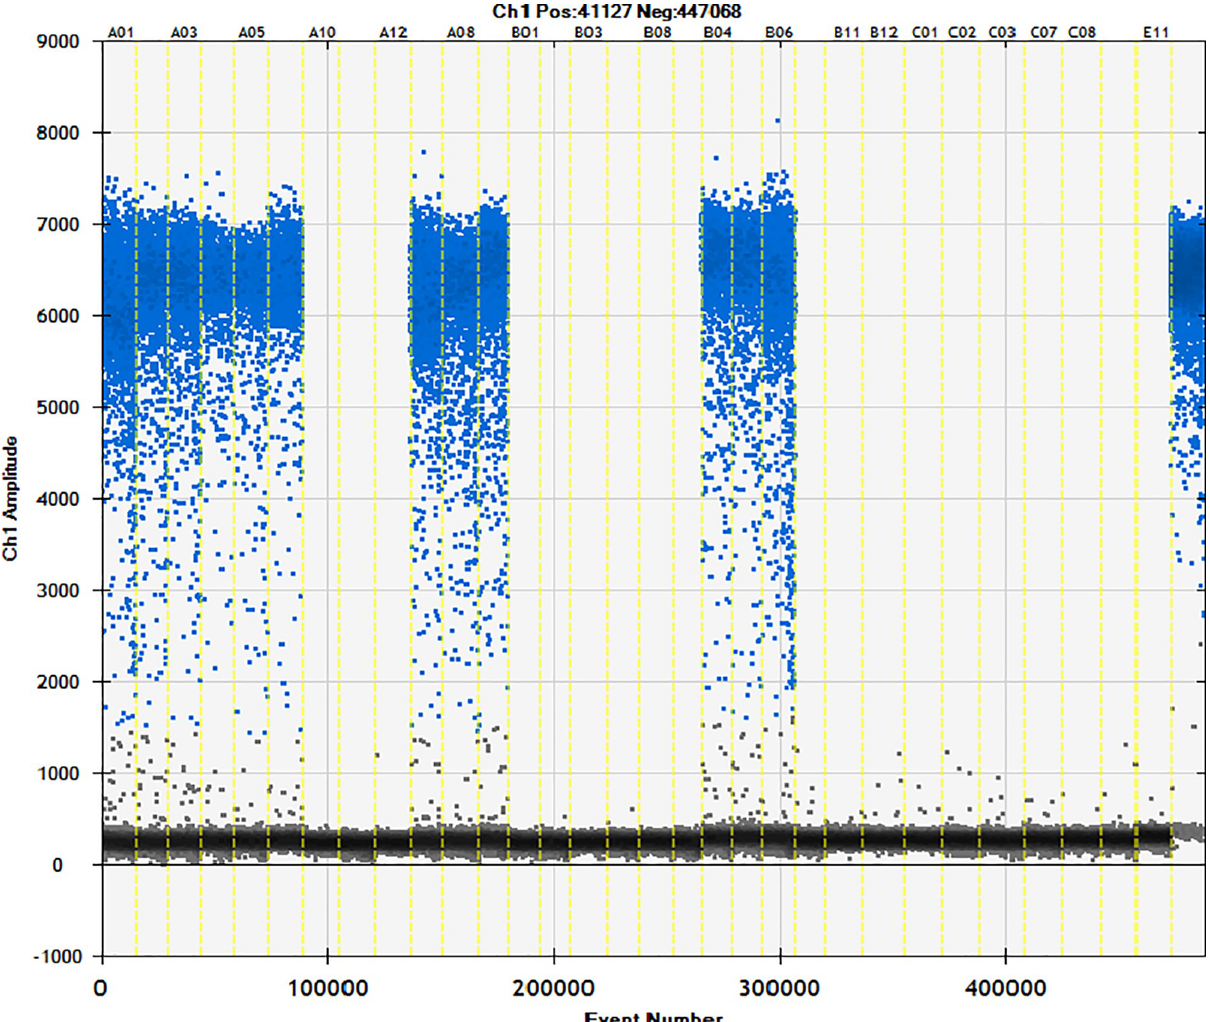
Fig 9. Actual test of commercially available samples. Channel 1–3: sample31; channel 4–6: sample32; channel 7–9: sample23; channel 10–12: sample24; channel 13–15: sample25; channel 16–18: sample26; channel 19–21: sample27; channel 22–24: sample28; channel 25–27: sample29; channel 28–30: sample30; channel31 negative; channel32